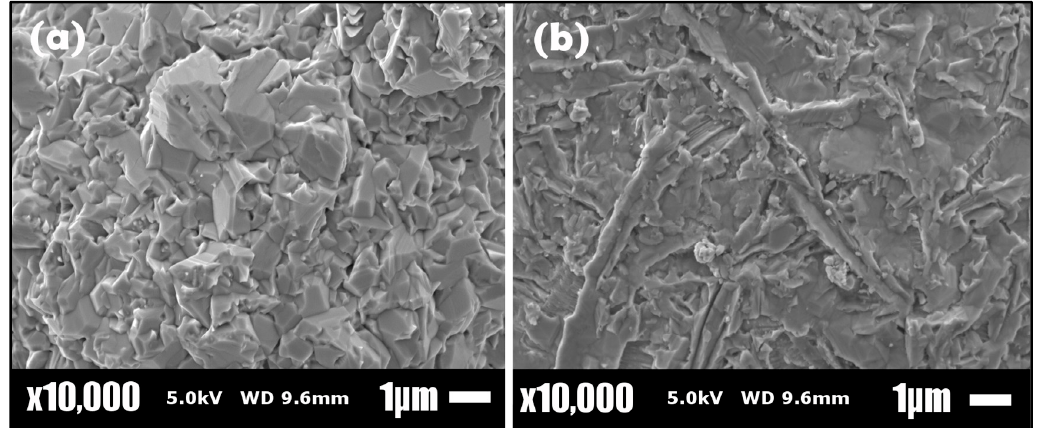
Figure 11. FESEM measurements on the shell from ( a ) undoped ZnO film, and ( b ) ZnO:Ta-doped film obtained with 300 mg of Ta 2 O 5 in the pellet.